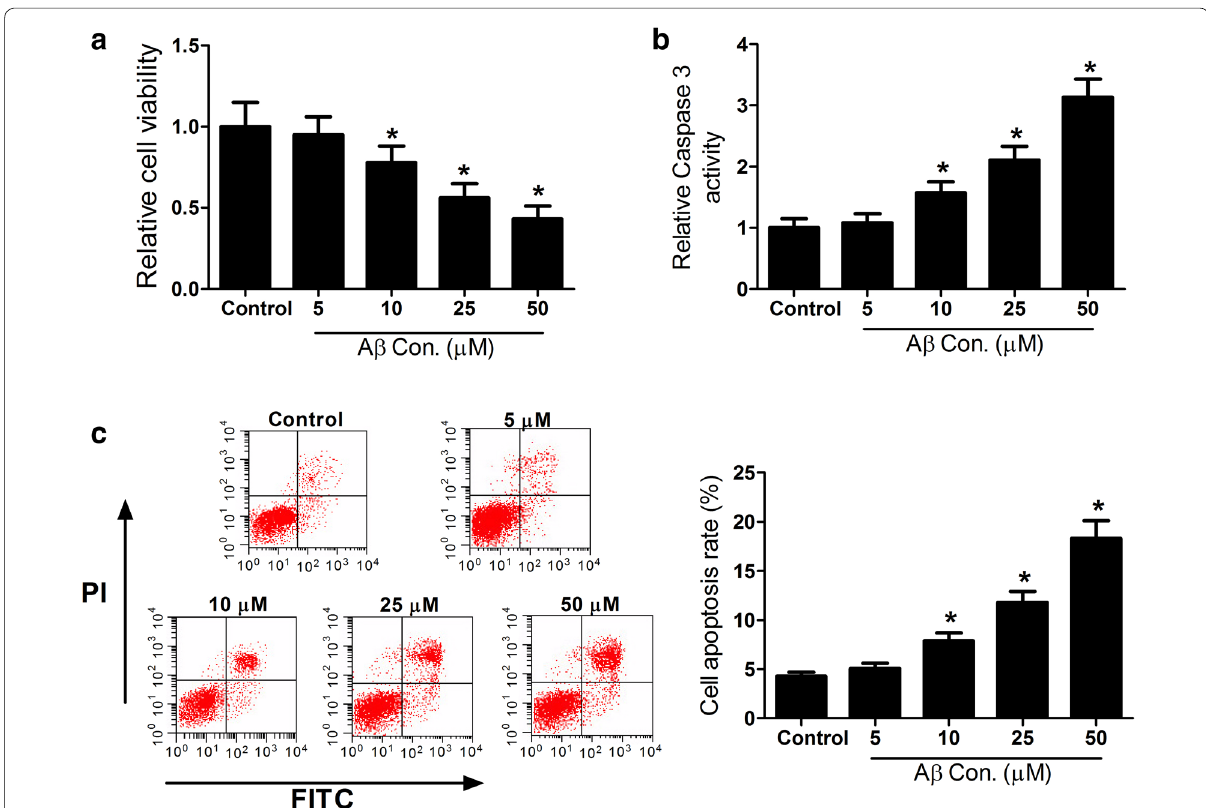
Fig. 1 Aβ treatment suppressed cell viability and induced apoptosis in SH-SY5Y cells. SH-SY5Y cells were exposed to different concentrations (0, 5, 10, 25, 50 μM) of Aβ for 48 h. a MTT assay was conducted to determine the viability. b ELISA assay was performed to detect the caspase3 protein level. c Flow cytometry analysis was applied to determine apoptotic rate. * p < 0.05 vs.